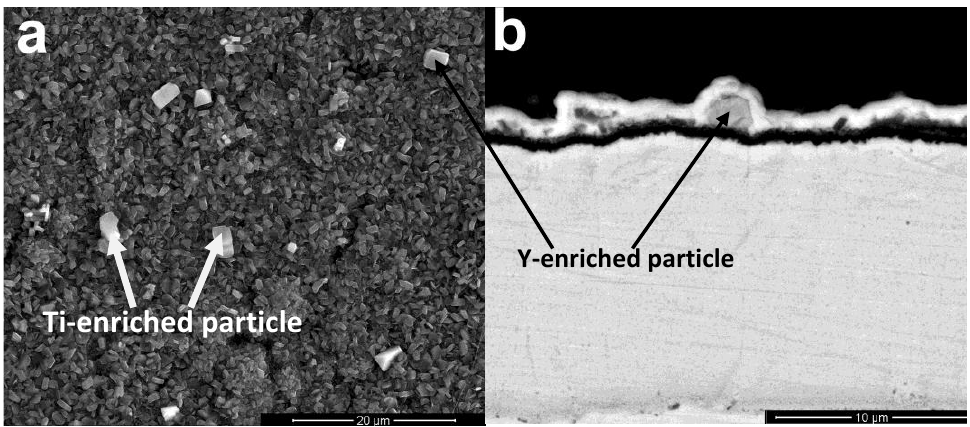
Figure 4. The ( a ) surface and ( b ) cross-sectional morphology of Y-enriched particle formed on the K38-0.5Y coating surface after 60 h at 900  C.